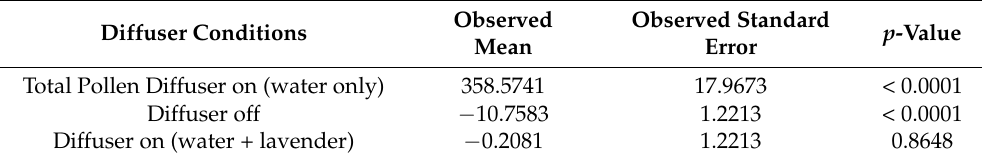
Table 5. Mean and standard error for each set of experimental conditions run on pecan pollen. The values for the different experimental conditions represent the averaged values of the additional or decreased amounts of pollen relative to the count for Total Pollen Diffuser on (water only).